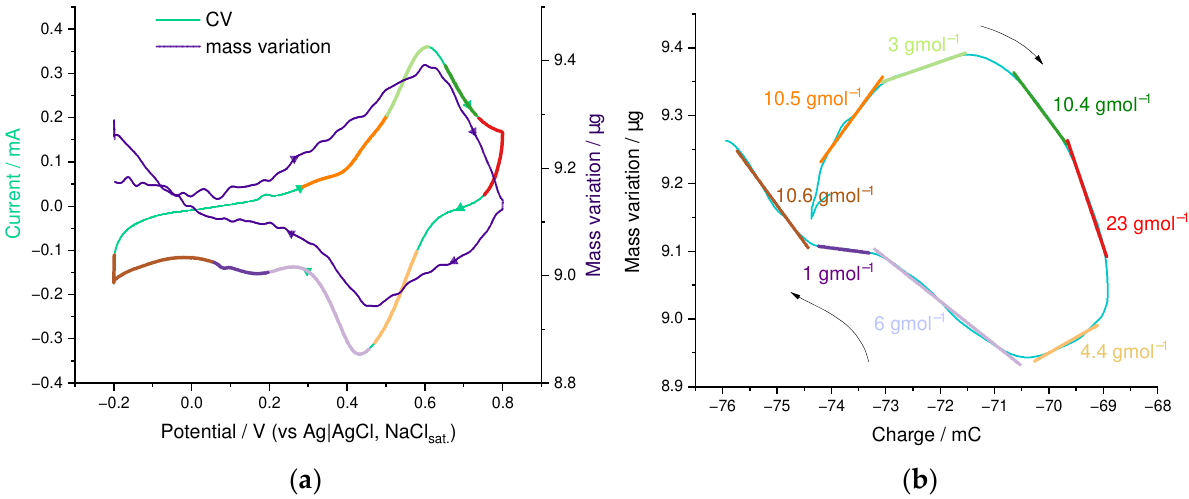
Figure 8. ( a ) Superimposed CV and Δ m ( E ) curves and ( b ) Δ m ( C ) curve with m / z slopes from EQCM experiment at 50th cycle, 0.1 M HclO 4 /H 2 O, 20 mV · s − 1